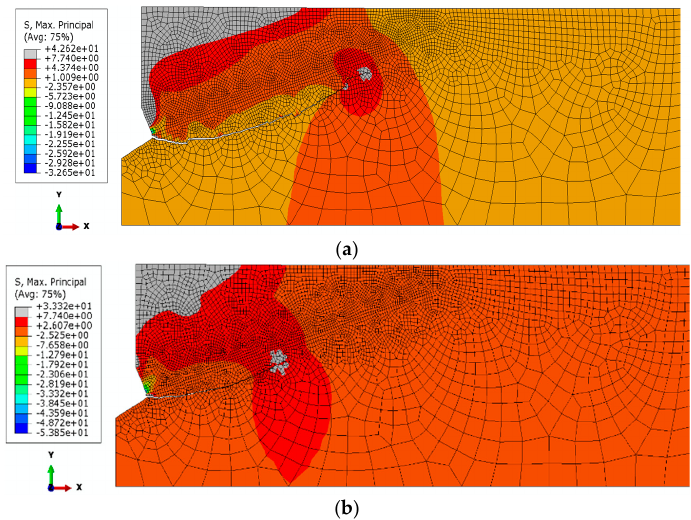
Figure 9. The course of the damage propagation and the distribution of maximum stresses: elastic modulus—E I = 14,276 MPa, Poisson’s ratio ν = 0.25, β = 25°, ( a ) μ 1 = 0.2, ( b ) μ 2 = 0.4.